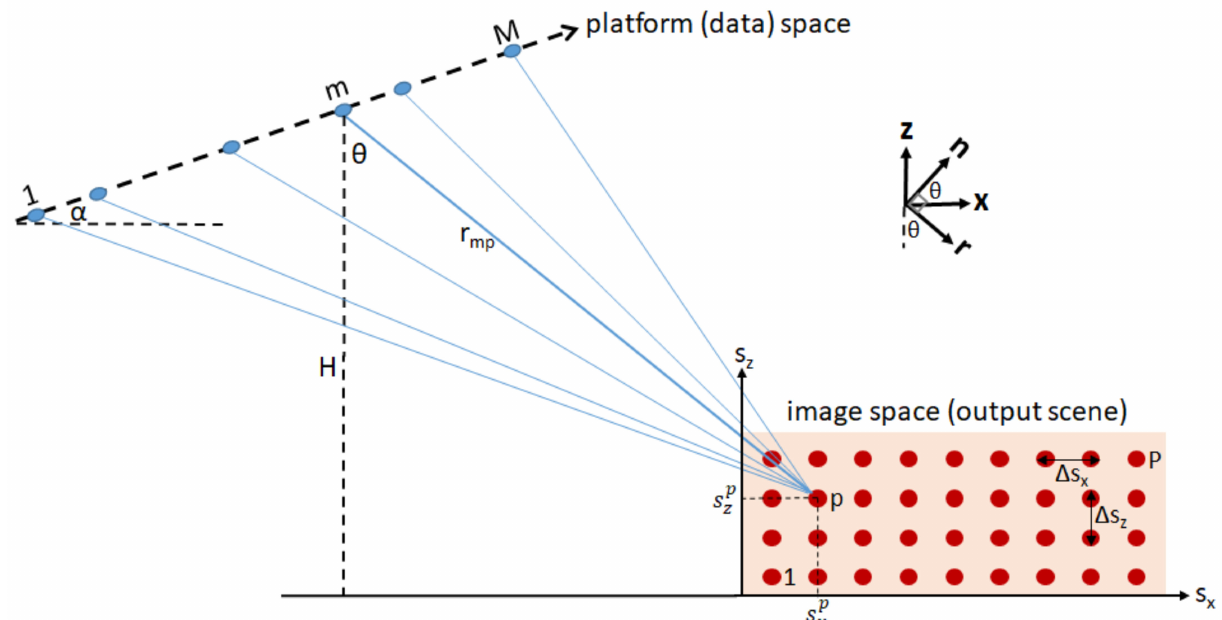
Figure 11. The geometry used in tomographic image generation in 2D. Blue and red circles represent platforms and image pixels, respectively. Platforms are distributed along the baseline which is tilted by α relative to horizontal. Image pixels are homogenously distributed in a 2D grid along vertical and horizontal. Look angle is θ